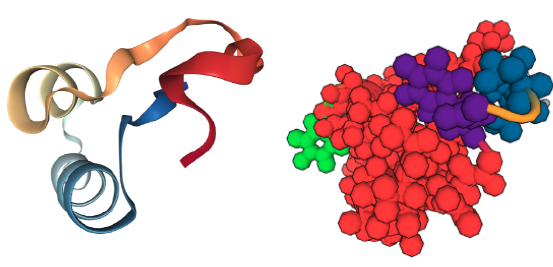
Figure 1. The rigidity analysis of a protein (PDB 1CRN, ( left )) identifies rigid clusters of atoms ( right ). Rigidity